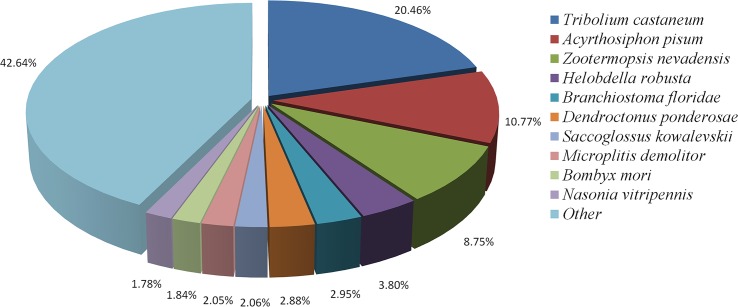
Species distribution of unigene BLASTX results.Unigenes were searched against the NR protein database using BLASTX tool with a cutoff e-value <10−5. Proportions of each species were represented by different colors and graphed. Species with proportions less than 1% were not shown.